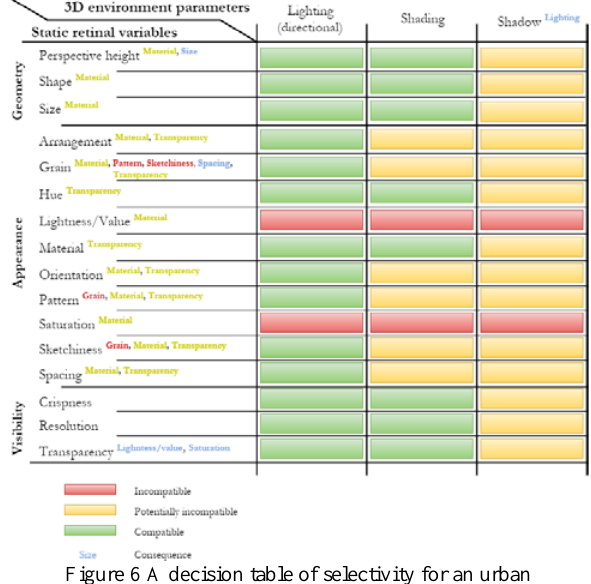
Figure 6 A decision table of selectivity for an urban visualisation at high density (part